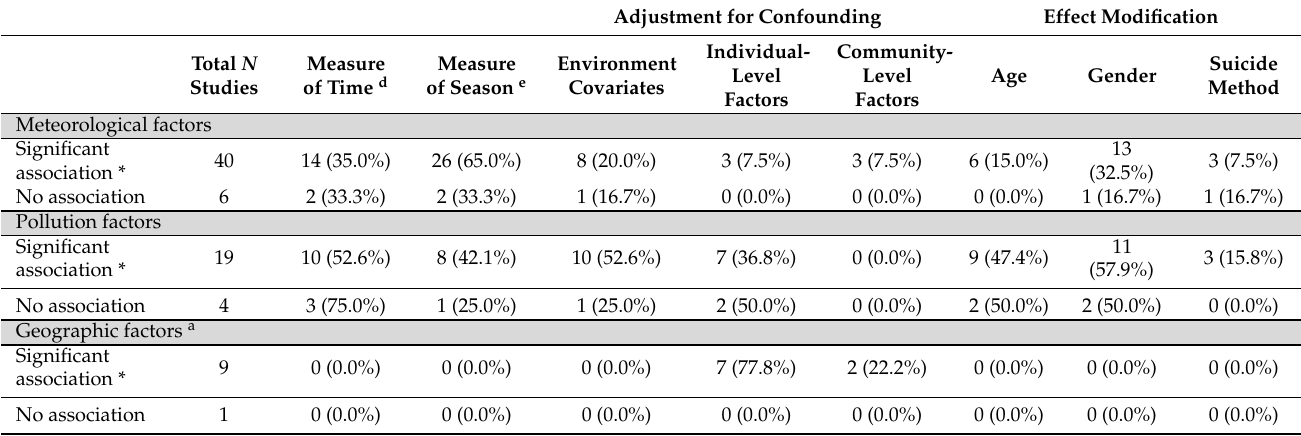
Table 5. Measures of confounding and effect modification across studies included in